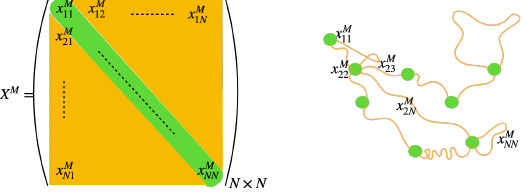
Figure 1. The holographic picture of the matrix model. One matrix gives information for the D0- branes in one spatial dimension and we have nine of them. This way we are constructing nine- spatial dimensions where the D0-branes live and dynamics are generated upon integration over the time